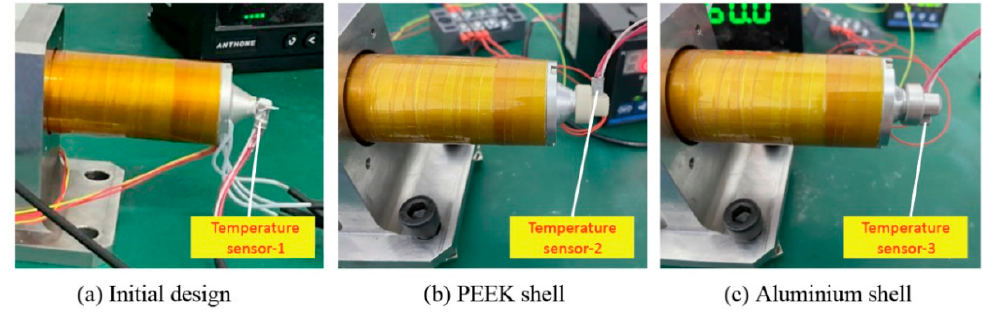
Figure 5. Steady-state temperatures with varying target temperatures.